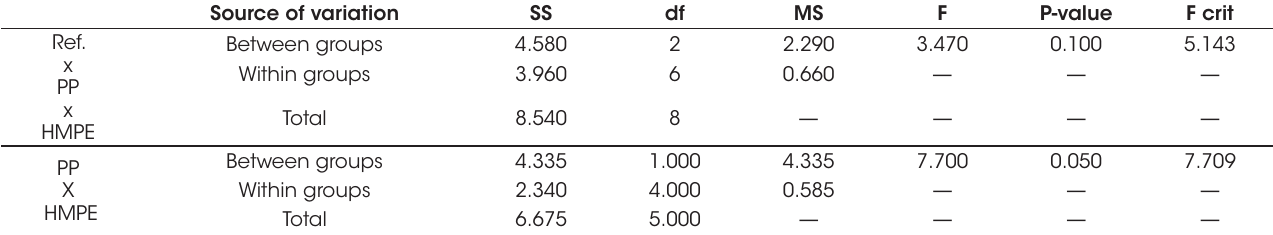
Statistical analysis of variance (ANOVA, p<0.05) for compressive strength, between reference concrete (Ref.), PP fiber concrete (PP) and HMPE fiber concrete (HMPE)